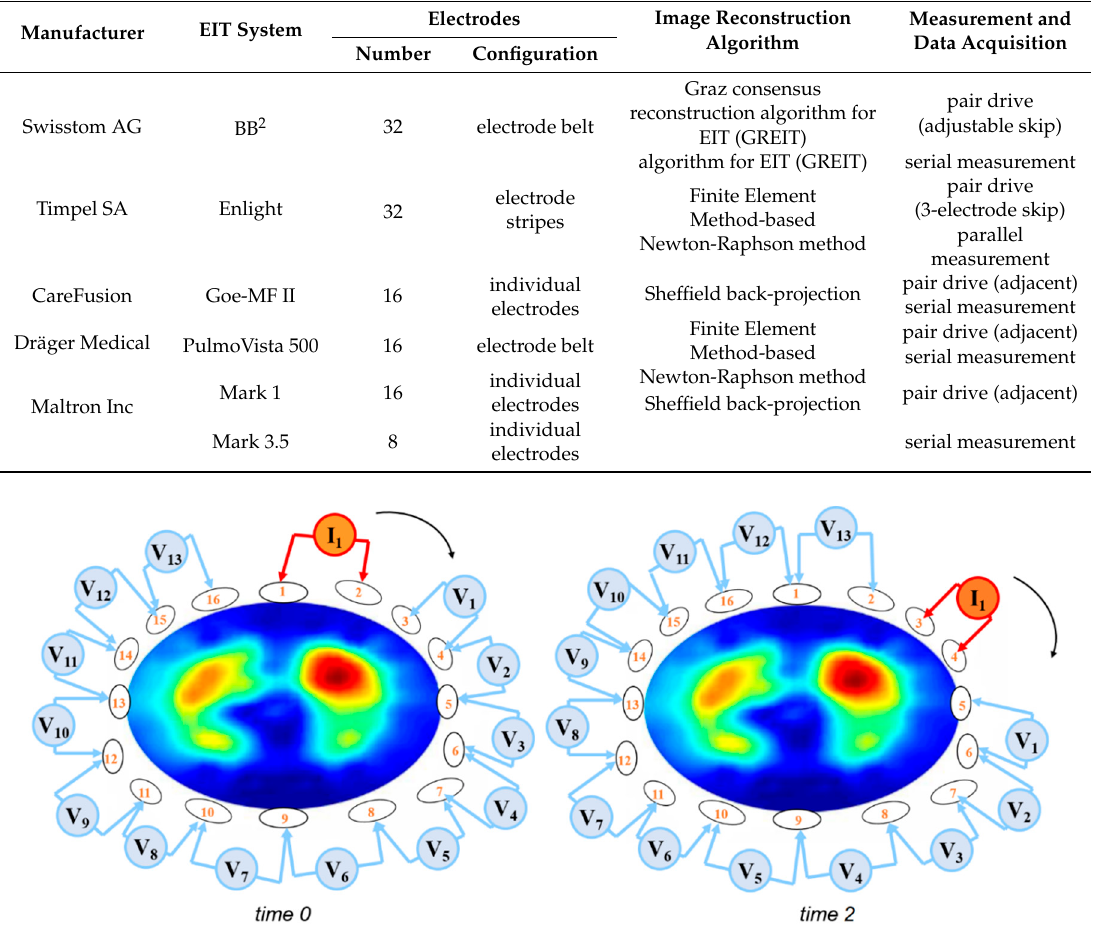
Figure 1. Current application and voltage measurements around the thorax using an EIT system with 16 electrodes. Within a few milliseconds, both the current electrodes and the active voltage electrodes are repeatedly rotated around the thorax.